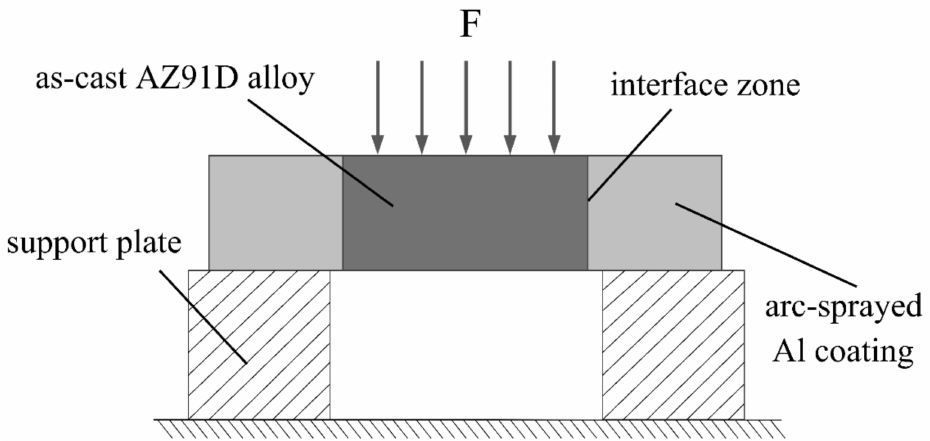
Figure 2. Schematic illustrations of the push out test.